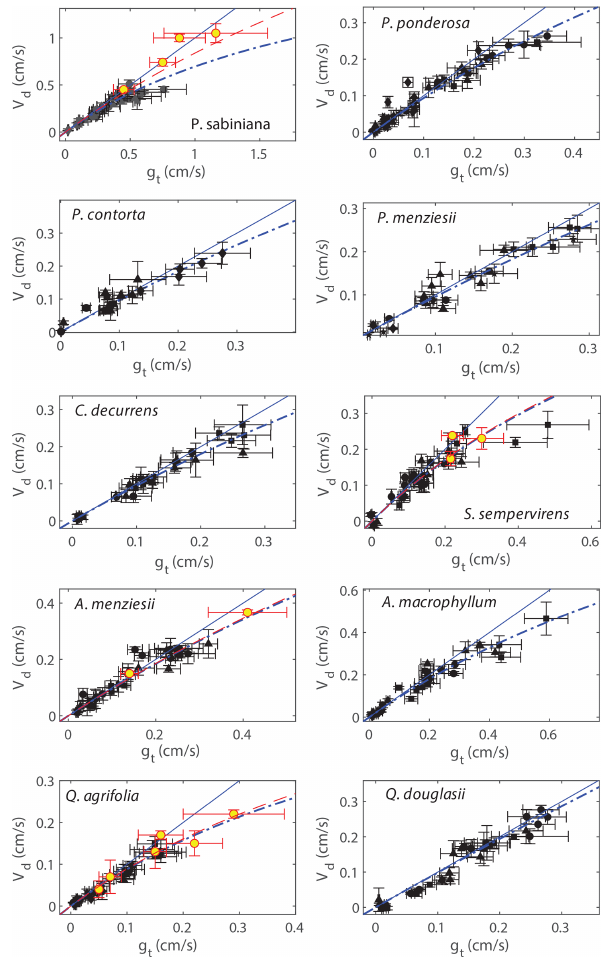
Figure 3. Deposition velocities ( V d ) plotted against measured total conductances to NO 2 ( g t ). Black markers represent measurements in zero air, and red–yellow markers are measurements in helium. Measurements in helium are subject to less uncertainty introduced by potential systematic error in the leaf temperature. Solid blue lines are the 1 : 1 line, and dashed blue lines are error-weighted fits to the resistance model using only measurements in zero air, assuming the boundary layer resistance is negligible (Eq. 4). Fits to the resis- tance model including data from helium measurements are shown as dashed red lines.